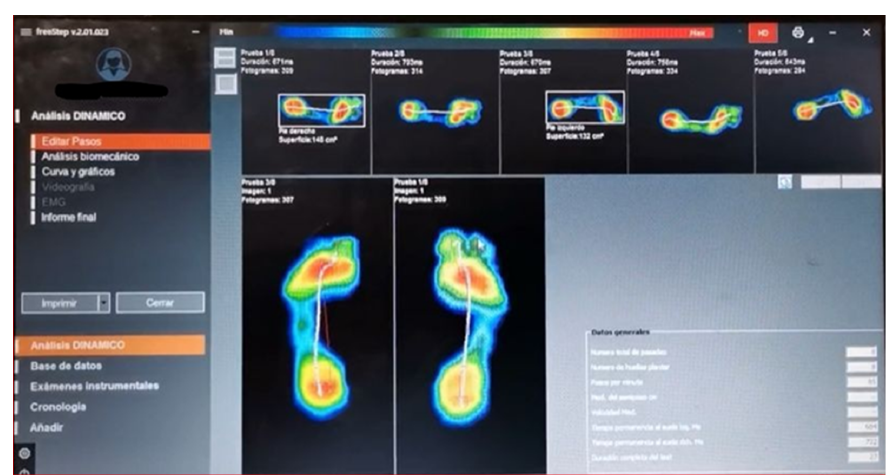
Figure 1. Pedigraph.